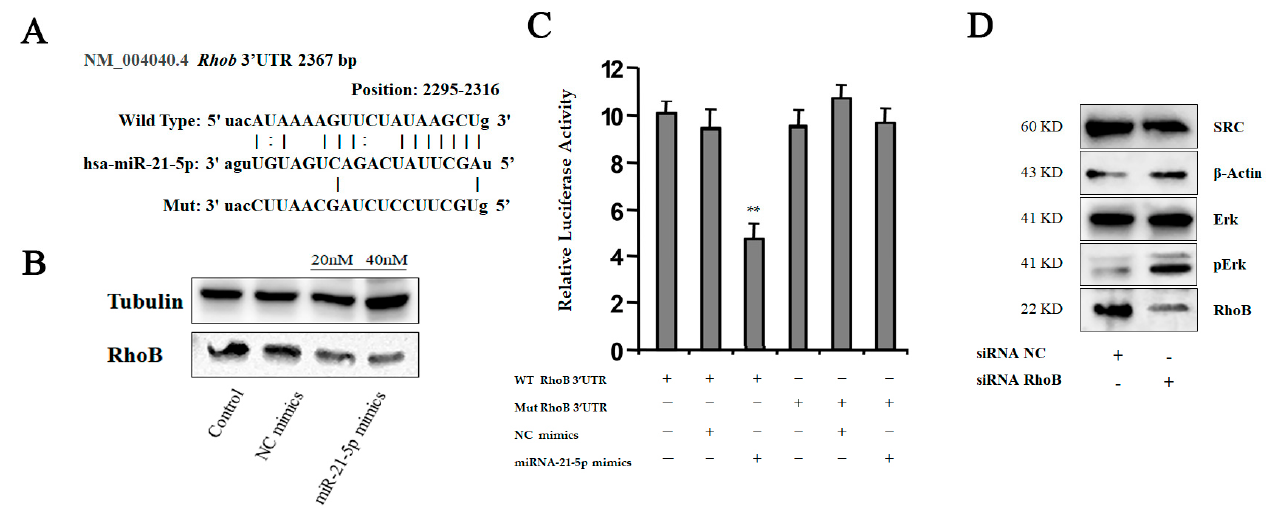
Figure 6. RhoB is the direct target for miR-21-5p in polarization of macrophages. ( A ) Sequence diagrams showing wild type and mutant type RhoB 3 ′ UTR for miR-21-5p. ( B ) We transfected miR-21-5p mimics into THP-1 cells using lipofectamine 2000 and detected RhoB level using Western-blot analysis. ( C ) Reporter assay: THP-1 cells were transfected with wild type or mutant type RhoB 3 ′ UTR vectors as indicated. After 24 h, the cells were infected with miRNA mimics. 14 h later, luciferase activity of reporters was measured, ** p < 0.05. ( D ) We transfected RhoB siRNA into THP-1 cells, and detected protein levels using Western-blot analysis as indicated.